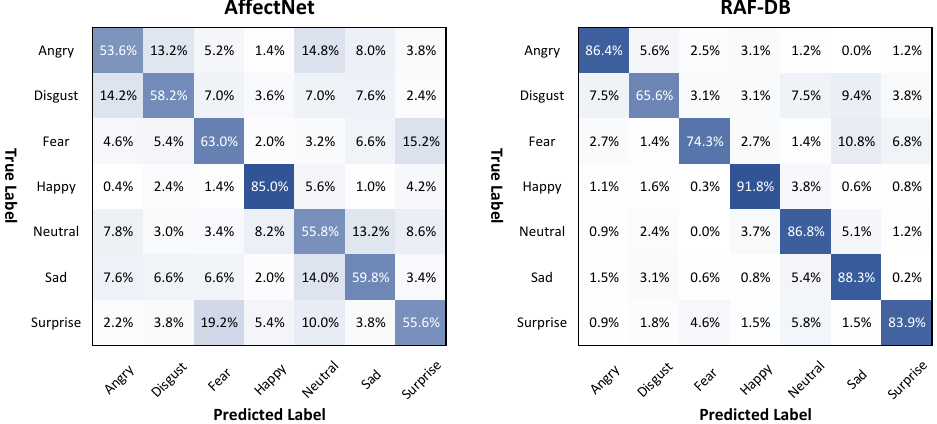
Figure 10. Confusion matrix of ResNet 50 model on the AffectNet and RAF-DB validation